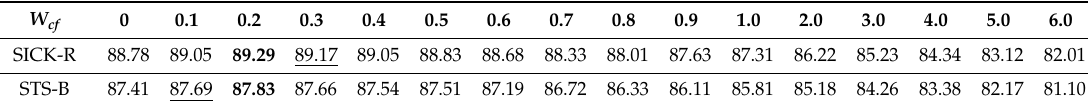
Figure 3. Pearson’s ( r ) of different weight factors. The horizontal axis is the range of weight factor W cf , and the vertical axis is the correlation coe ffi cient. The two auxiliary horizontal lines represent the value when W cf = 0 (method without CF) to facilitate comparison with all the results. The variation of similarity between STS and SICK-R is roughly consistent. Table 7. Pearson correlations of different weight factors for CF-BERT LARGE .